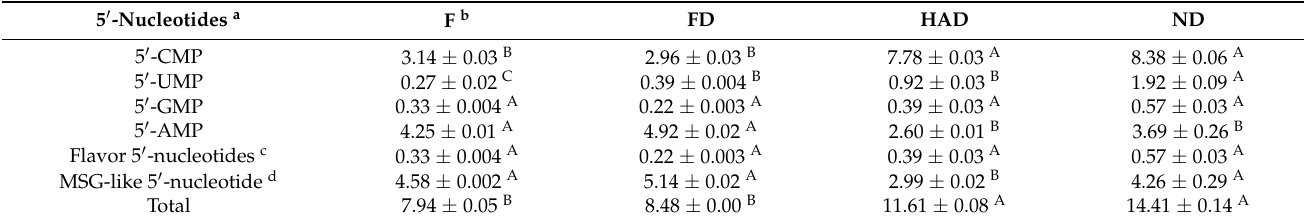
Table 4. 5 (cid:48) -nucleotides in fresh and different dried L. edodes .